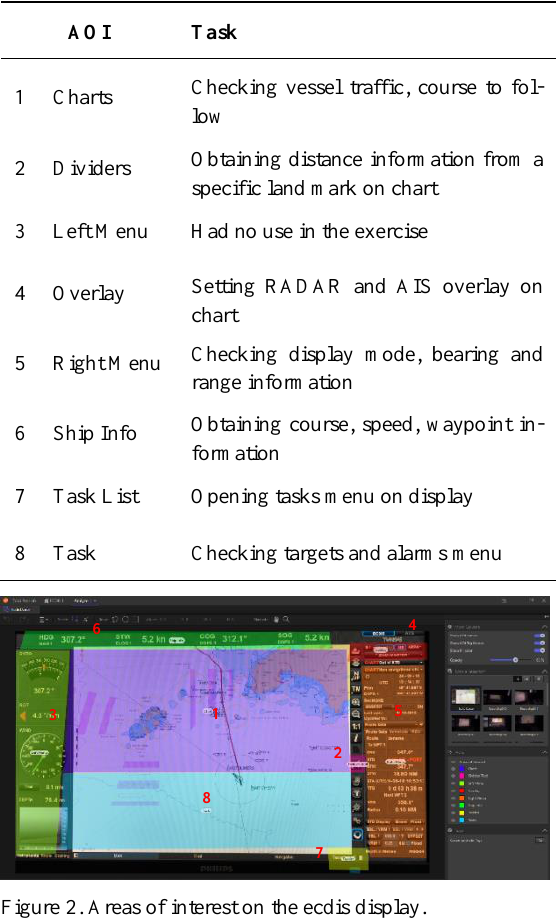
Figure 2. Areas of interest on the ecdis